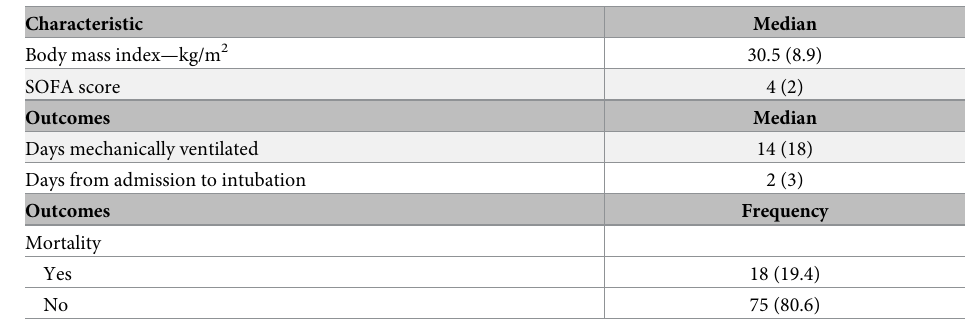
For categorical variables, column percentages are in parenthesis. For the continuous variable age, mean and standard deviation are reported; for the continuous variables body mass index (BMI), Sequential Organ Failure Assessment (SOFA) score, days on mechanical ventilation, and days from admission to intubation, median and interquartile range are reported. Days requiring mechanical ventilation and mortality were collected for 28 days post admission.